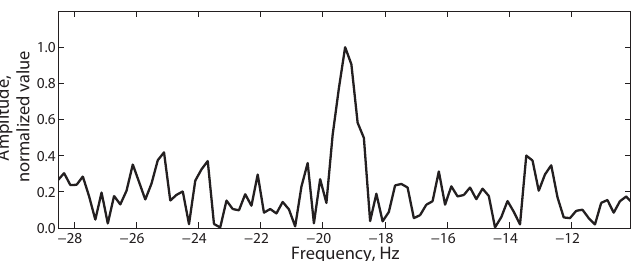
Fig.5. The spectrum of signal derived from the correlation between the signal transmitted by the Evpatoria antenna and reflected echo recorded at Irbene. Horizontal axis represents the difference between the measured Doppler frequency shift and the frequency derived from the preliminarily known data. Integration time was 5 s, observed on 2013 February 16, 04:53:02